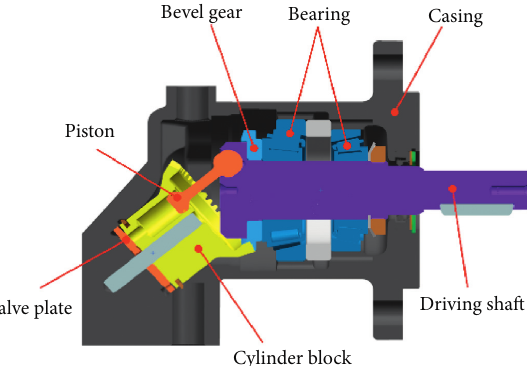
Figure 1: The configuration of a bent-axis piston pump.